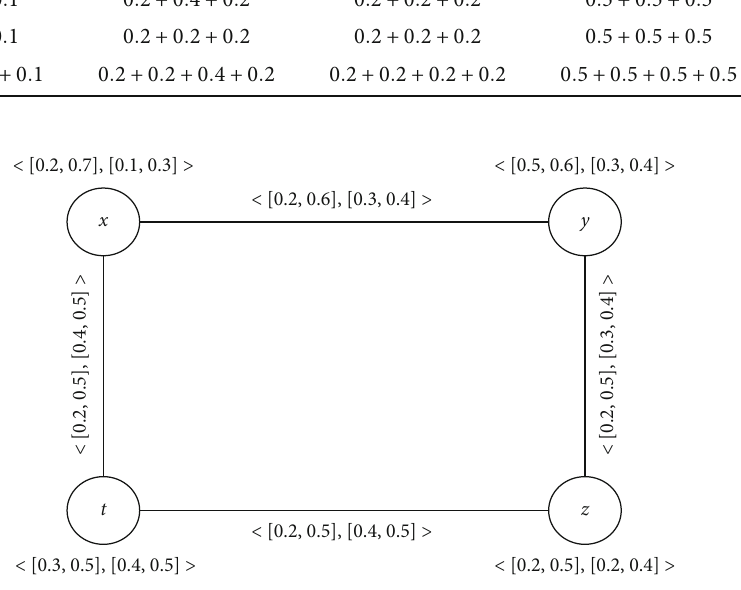
Figure 2: A strong IVIFG G for a strong independent set (SIS).